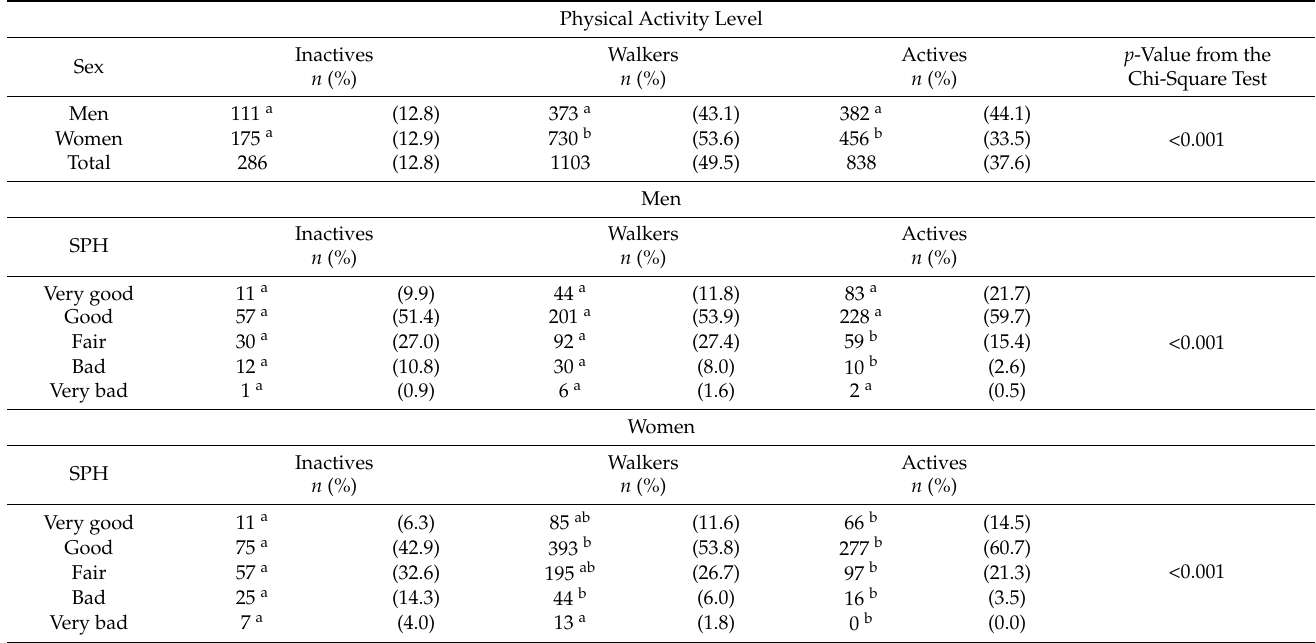
Table 3. Associations between the physical activity level and self-perceived health in informal caregivers according to the Spanish National Health Survey 2017.